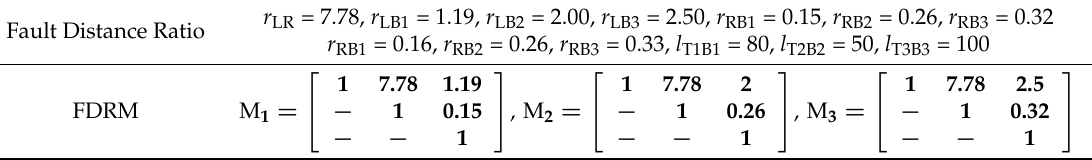
Table 4. Fault distance ratios and fault distance ratio matrixes (FDRMs). Fault Distance